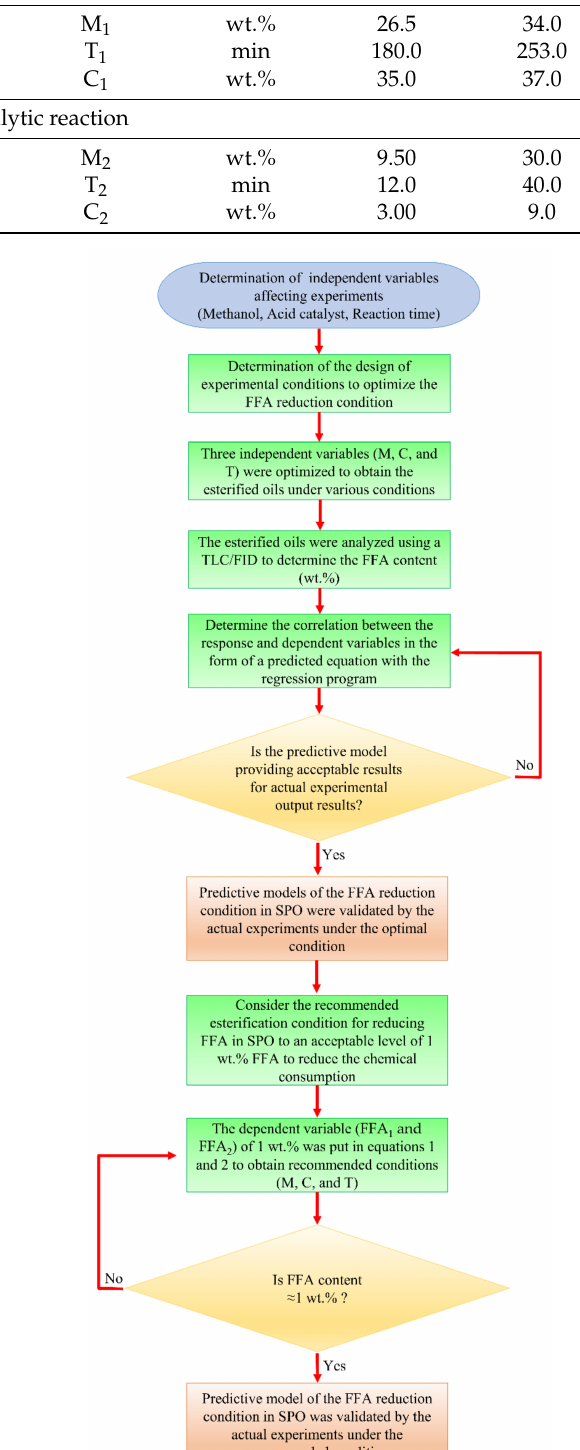
Figure 7. Flowchart methodology of this